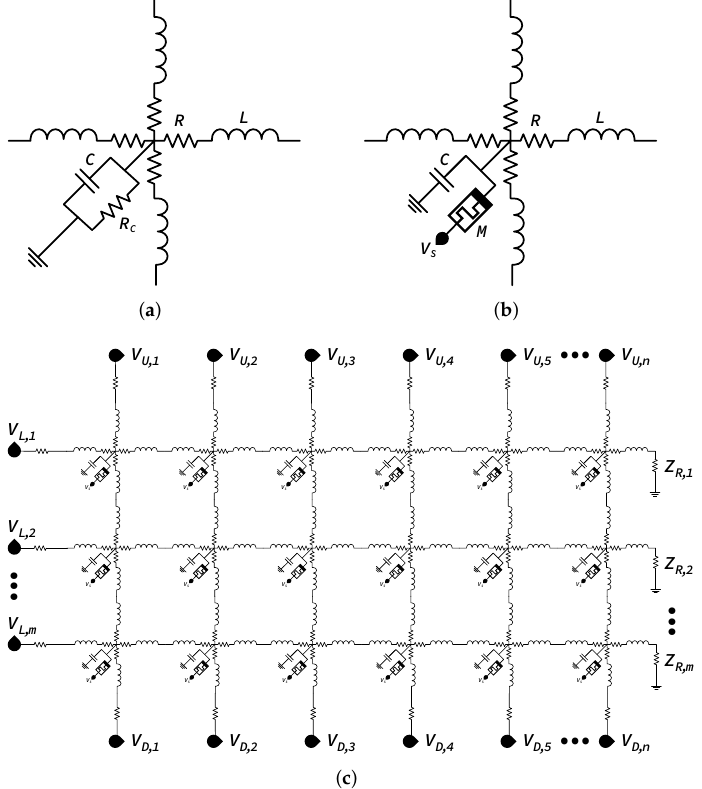
Figure 10. ( a ) RLC circuit which corresponds to a transmission line and ( b ) the modified circuit including a memristor (R = 0.01 Ω , L = 1 mH, C = 10 µ F). ( c ) A 2D topology of the respective M - RLC